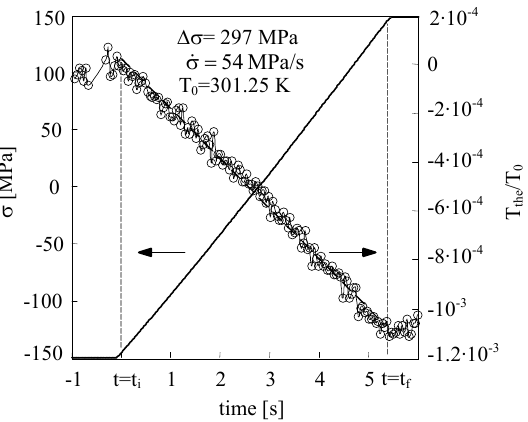
Figure 7: Example of static test and measured thermoelastic temperature variation.